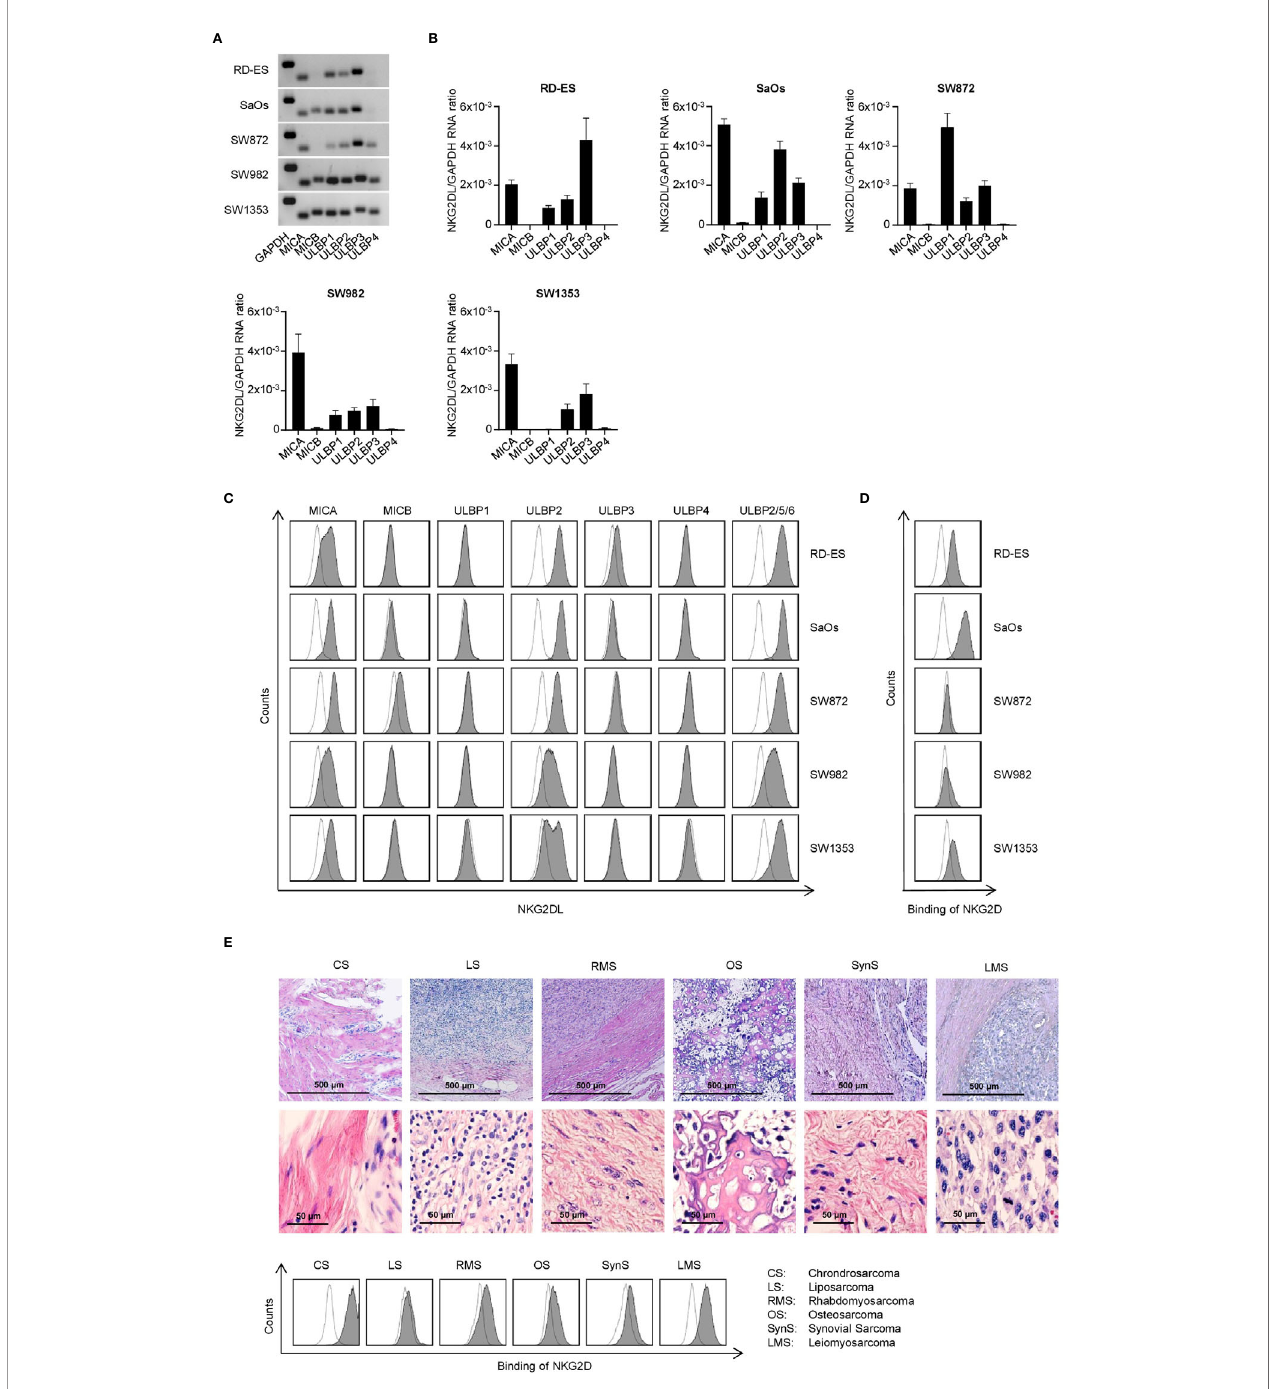
FIGURE 2 | Characterization of NKG2DL expression in STS cell lines. (A) MICA, MICB and ULBP1-4 mRNA expression was determined via RT-PCR with GAPDH serving as control. PCR products were visualized by agarose gel electrophoresis. (B) Relative mRNA expression of MICA, MICB and ULBP1-4 in fi ve different STS cell lines was determined as described in the method section. Results for n=3 experiments are shown. (C) Surface expression of MICA, MICB, ULBP1-4 and ULBP2/5/6 on the indicated cell lines was analyzed by fl ow cytometry. mAb against the depicted NKG2DL are shown as shaded peaks, corresponding isotype controls are shown as open peaks. (D) Binding of NKG2D to the surface of sarcoma cells lines was analyzed by fl ow cytometry using an NKG2D-Fc-chimera (shaded peaks) and the corresponding isotype control (open peaks). (E) H&E staining of paraf fi n-embedded tissue sections from primary sarcoma tissue was performed (upper panel). Patient-derived sarcoma cells dissociated from the primary tumor were analyzed by fl ow cytometry using a biotinylated NKG2D-Fc-chimera (shaded peaks) and the corresponding isotype control (open peaks) followed by strep